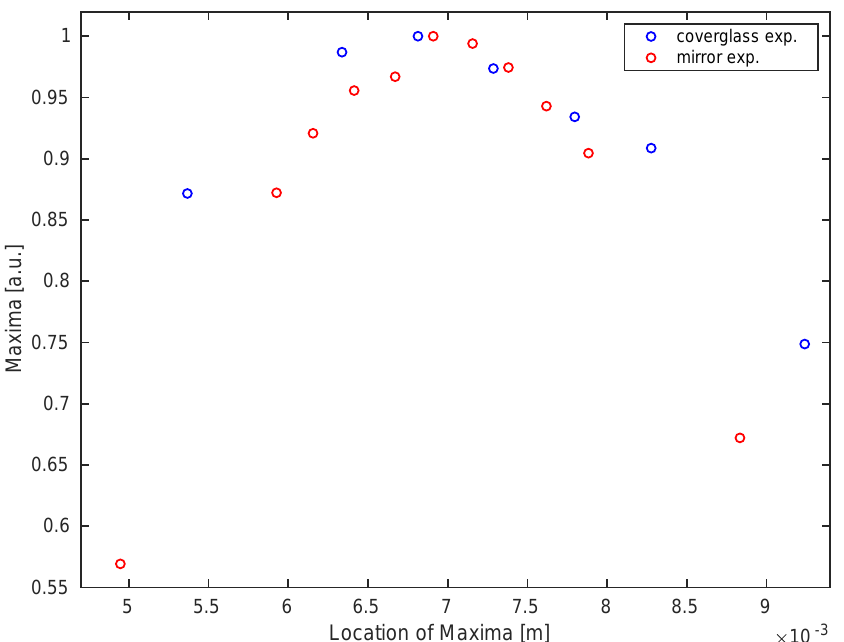
Figure 7. Comparison between averaged maximum values for all B-scans of the mirror (red) and the coverglass (blue) experiment.